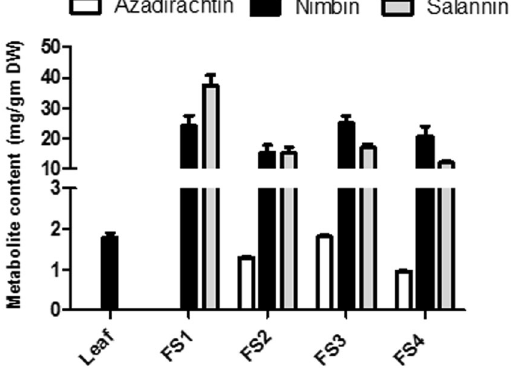
Figure 1. Phytochemical analysis of different plant parts of Azadirachta indica . Leaf, Mature leaf; FS1, Fruit stage 1; FS2, Fruit stage-2; FS3, Fruit stage-3 and FS4, Fruit